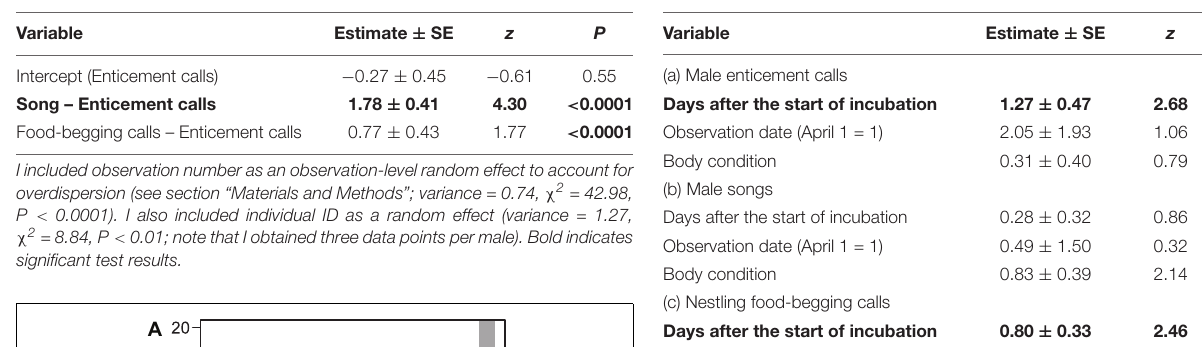
TABLE 1 | Multivariable generalised linear mixed-effects model (GLMM) with a Poisson error distribution predicting the number of male responses to the experimental playback of male enticement calls, male songs, and nestling food-begging calls during the incubation period ( n male = 17, n observation = 51).